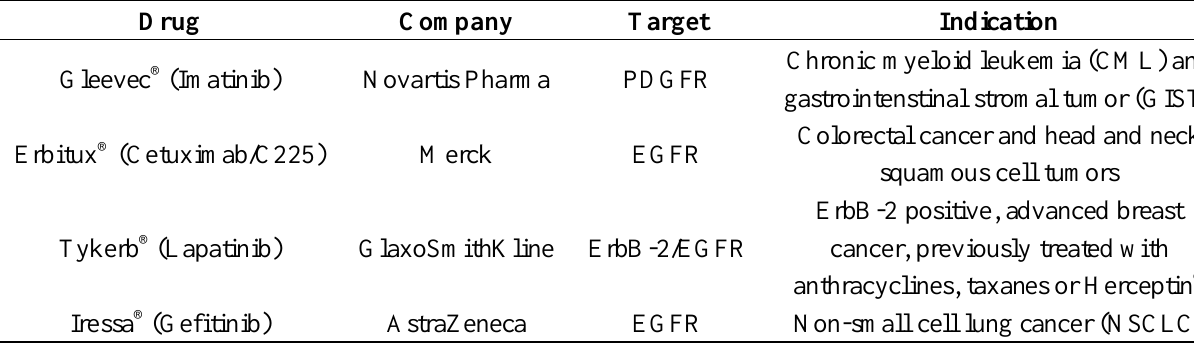
Table 1. Anti-tumor drugs targeted against cellular tyrosine kinase